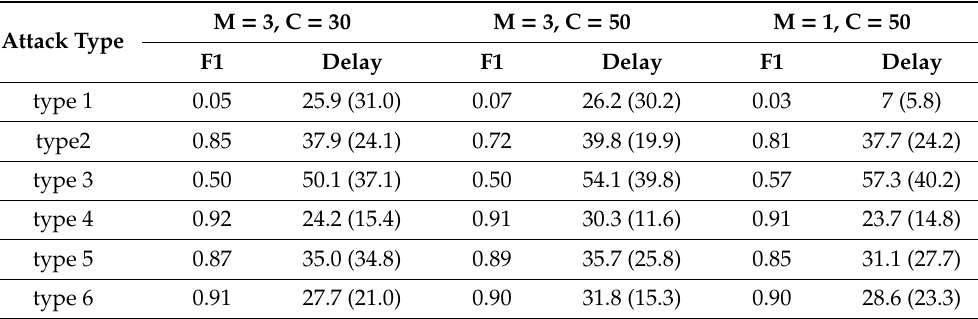
Table 3. The energy theft detection performance when an outlier detection model was constructed from past usage data of the consumer being monitored for energy theft